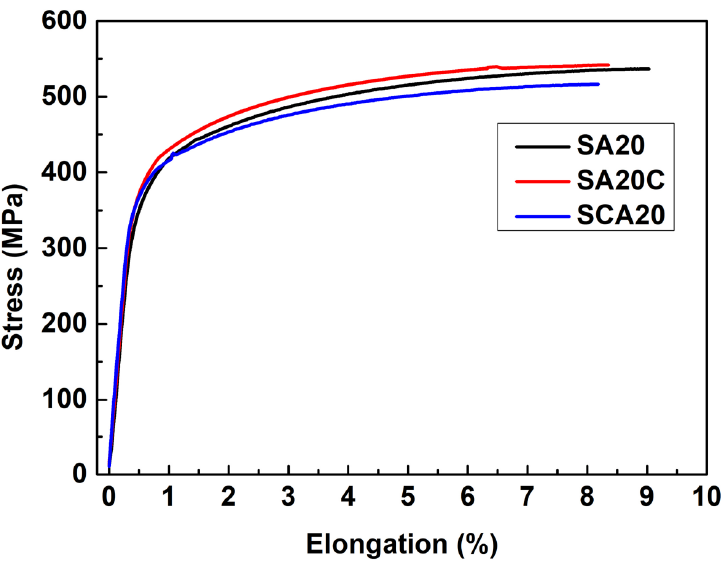
Figure 5. Stress – strain curves of specimens under different treatment conditions. Figure 5. Stress–strain curves of specimens under different treatment conditions.